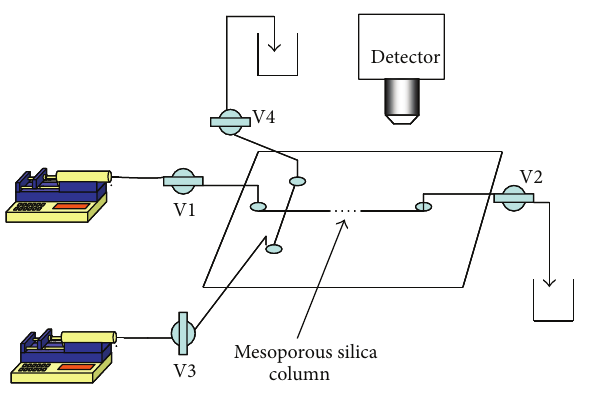
Figure 4: A chromatograph showing the single peak (fluorescein) observed right after the dyes mixture was injected into a separation channel at the flow rate of 0.23 𝜇 L/s.